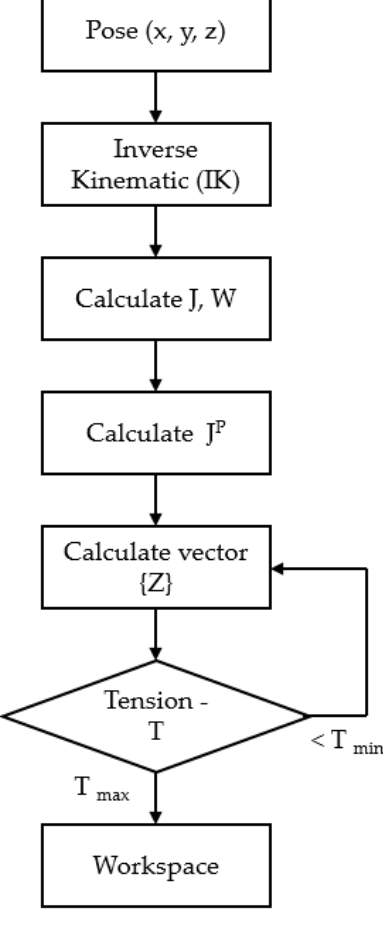
Figure 4. Flowchart of the proposed method .